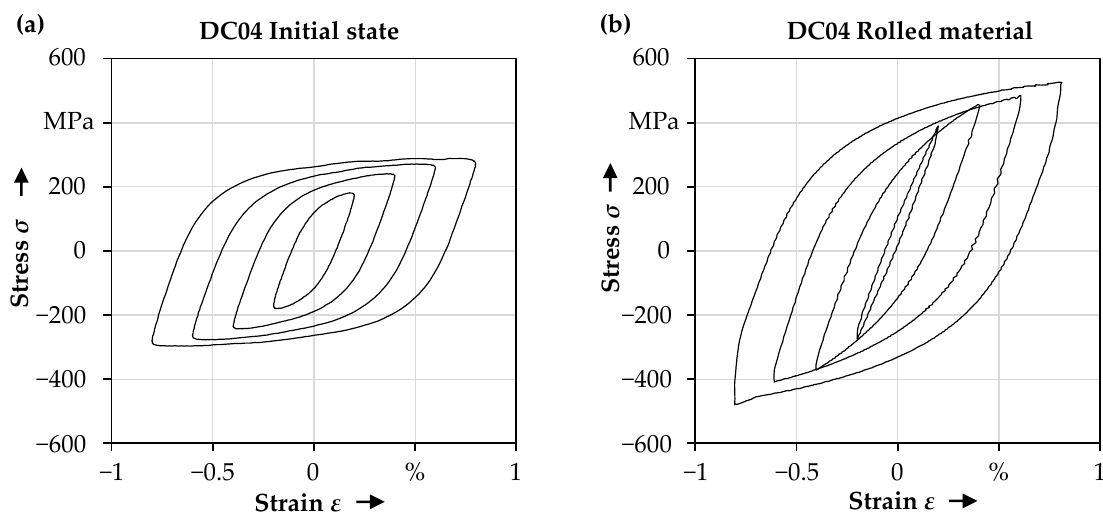
Figure 12. Hysteresis loops for the ( a ) initial state and ( b ) the rolled material state. Based on the upper reversal points of these hysteresis loops, cyclic stress–strain curves were determined as shown in Figure 13. These were employed as material data for the simulation of the resulting equivalent stress distribution at the form elements of the component under an assumed service load.